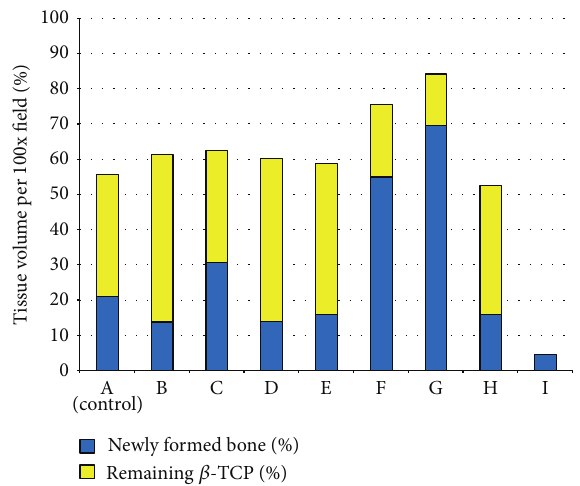
Figure 5: Percentage of newly formed bone and remaining 𝛽 -TCP eight weeks after surgery. Values are shown as mean. Capital letters A–I correspond to treatment groups. Note that newly formed bone occupies more than 50% of the central area of the defect in groups F and G. In addition, the percentage of newly formed bone exceeds that of remaining 𝛽 -TCP.